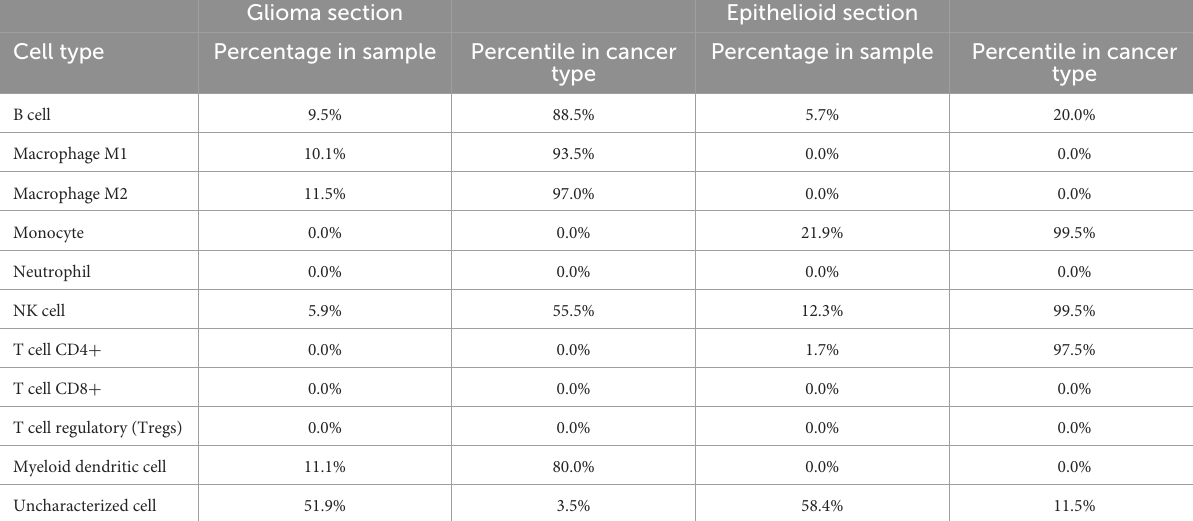
TABLE 2 Tumor immune cell content by immune cell whole-transcriptome